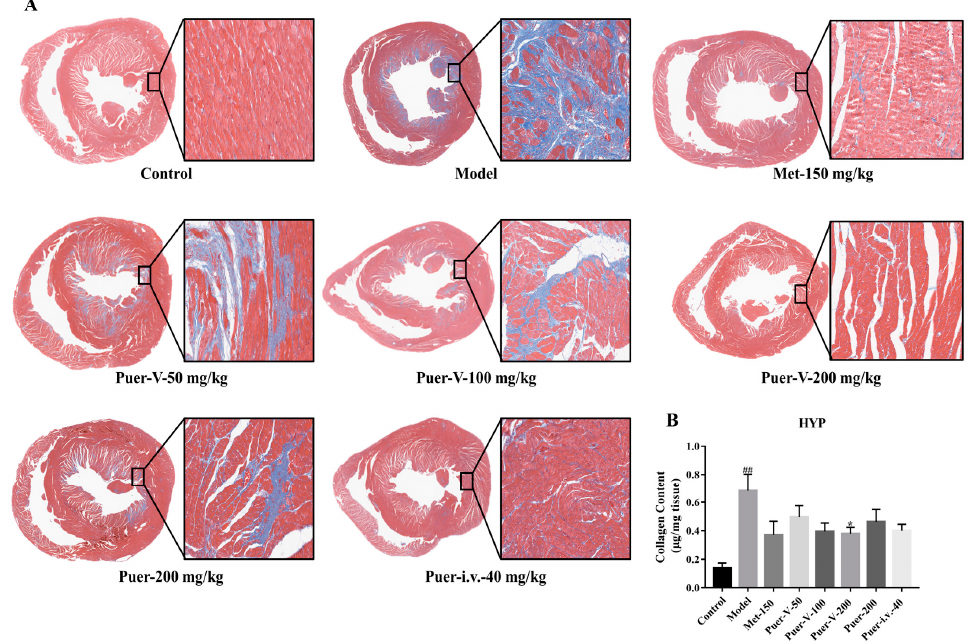
Figure 7. Puerarin-V inhibited the myocardial fibrosis in the DCM rats. ( A ) Fibrosis changes in myocardium of DCM rats (Masson staining). Left images are 2 × , right images are 20 × . ( B ) Effect of puerarin-V on left ventricular collagen content. The data are represented by mean ± SEM (n = 6–8). ## p < 0.01 vs. control group. * p < 0.05 vs. model group.